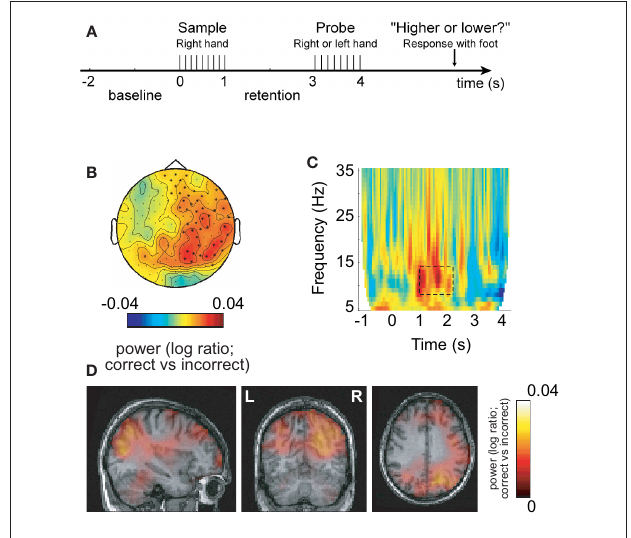
Figure 3 | Alpha activity in non-engaged sensorimotor areas predicts performance in a somatosensory working memory task. (A) Sample patterns of electrical stimuli were presented to the right hand. After a 2-s retention period subjects had to answer whether the frequency of the probe stimulus was higher or lower. (B) The 8–13 Hz alpha activity in the retention interval was compared with respect to correct and incorrect responses. The right hemisphere alpha activity was stronger for successful performance. (C) Time–frequency representations of power showed that the task-dependent effect was constrained to the alpha band in the retention interval. (D) The sources of the task-dependent alpha activity were localized in right sensorimotor and parieto-occipital regions. Reproduced from Haegens et al.